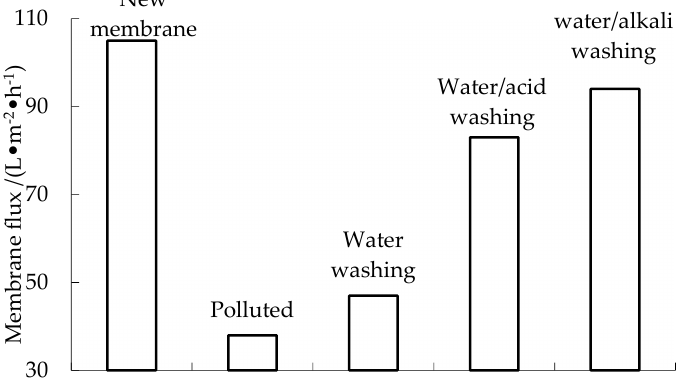
Figure 12. Recovery of membrane flux.